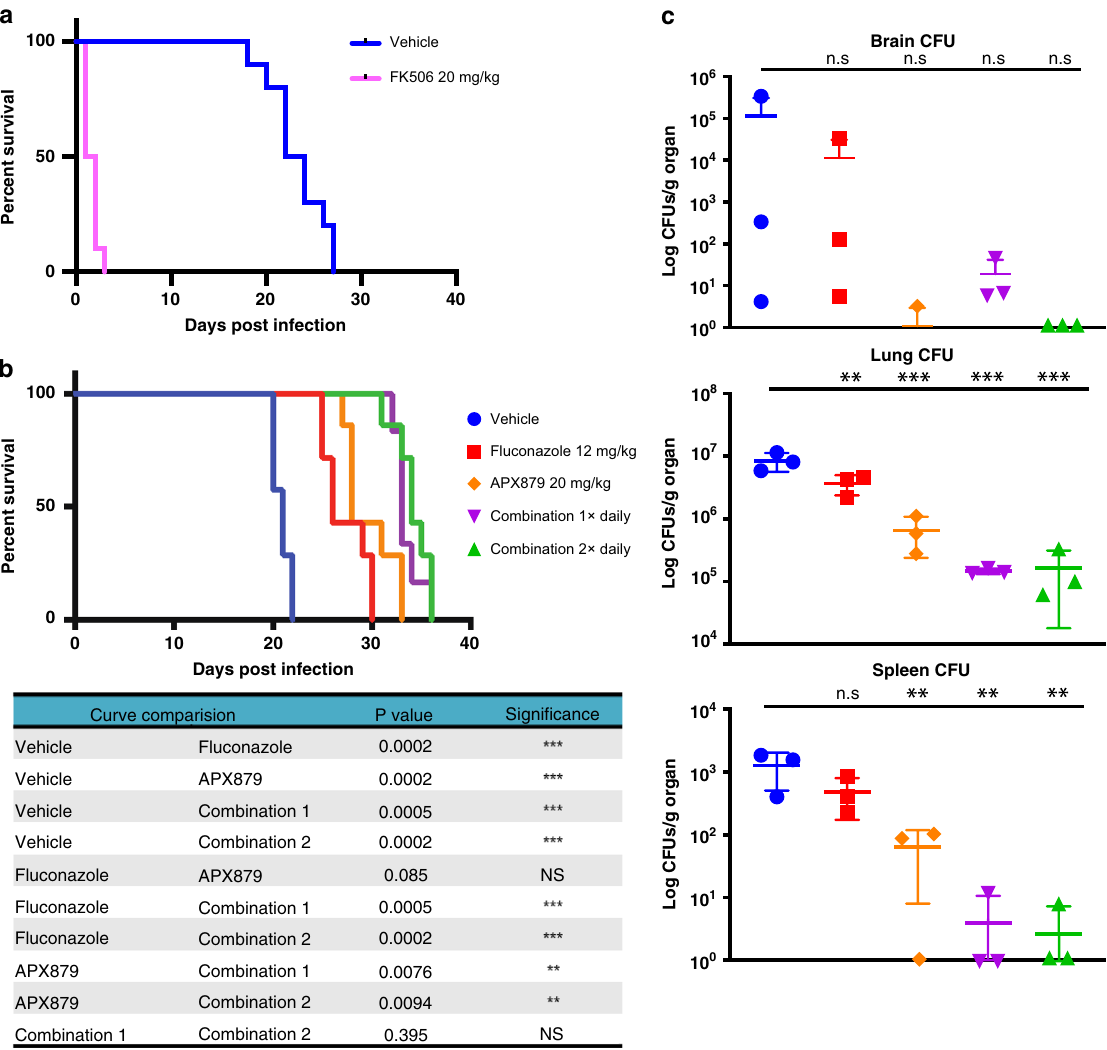
Fig. 7 Ef fi cacy of APX879 in cryptococcal model of murine invasive fungal infection. a , b Survival curve of mice infected intranasally with C. neoformans WT (H99) and treated daily with indicated antifungal drugs. Treatment was halted at day 14 and animals were monitored for survival. Survival curves analyzed using log-rank Mantel – Cox test. c Fungal burdens in brain, lung, and spleen of H99 infected and drug-treated animals. ** P < 0.01, *** P < 0.001. Lower error bars that exceeded the y -axis limits were excluded. See also Supplementary Fig.